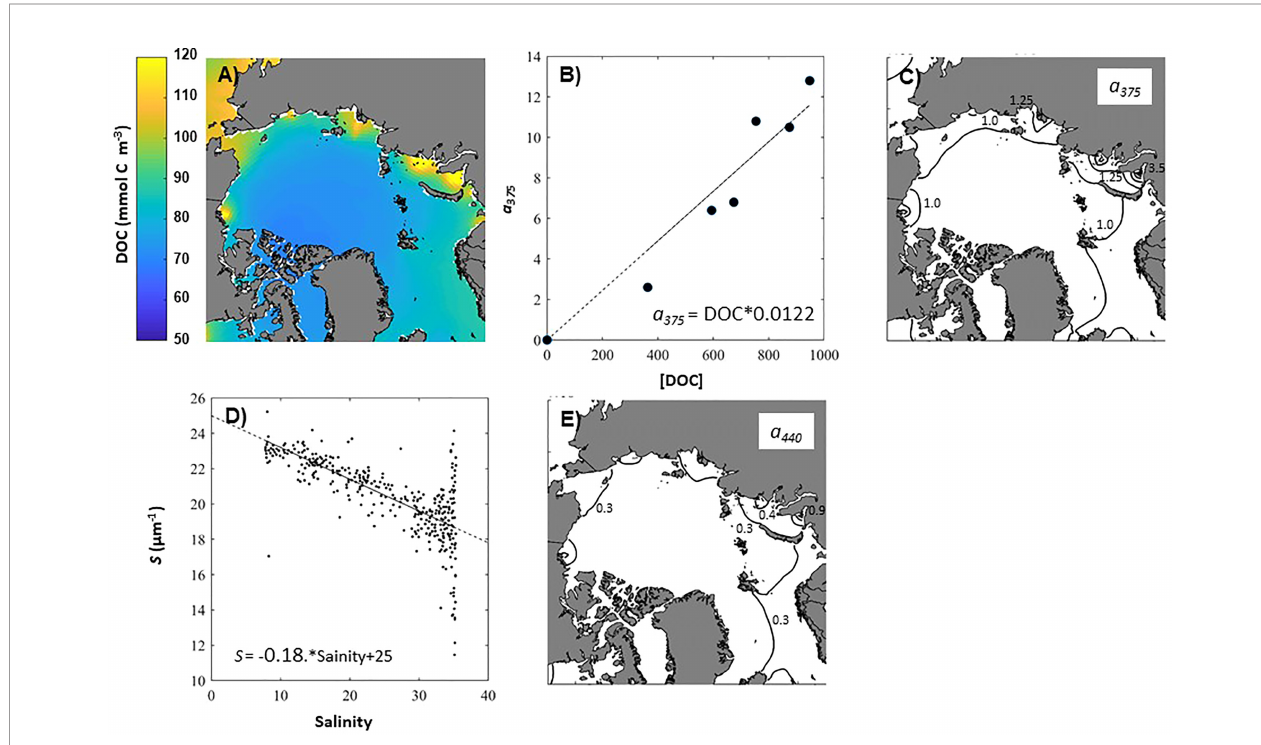
FIGURE 9 | Estimating the impact of DOC on the attenuation of light in the Arctic. Estimated June DOC concentration including labile and humics (A) , linear relationship between DOC and a 375 (B) , Estimation of a 375 (C) , linear relationship between spectral slope ( S ) and salinity (D) , and estimation of a 440 (E)